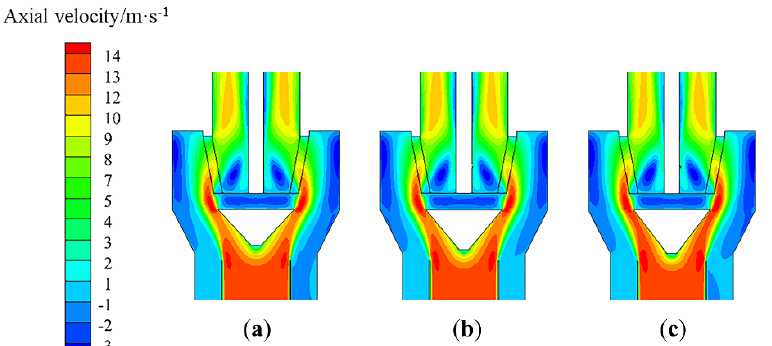
Figure 17. Effect of the height of the diversion cone on the axial velocity (T-C (1-0.8) , x = 0): ( a ) h = 94 mm, ( b ) h = 104 mm, and ( c ) h = 114 mm.